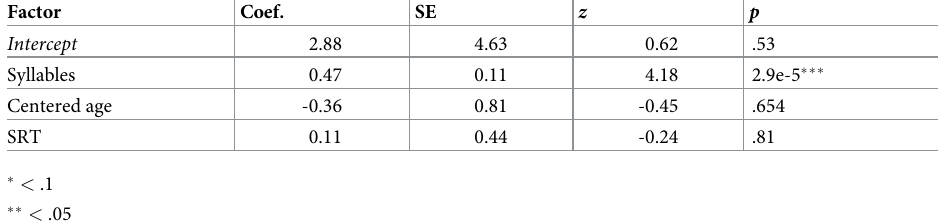
Table 2. Experiment 2 generalized linear mixed effect